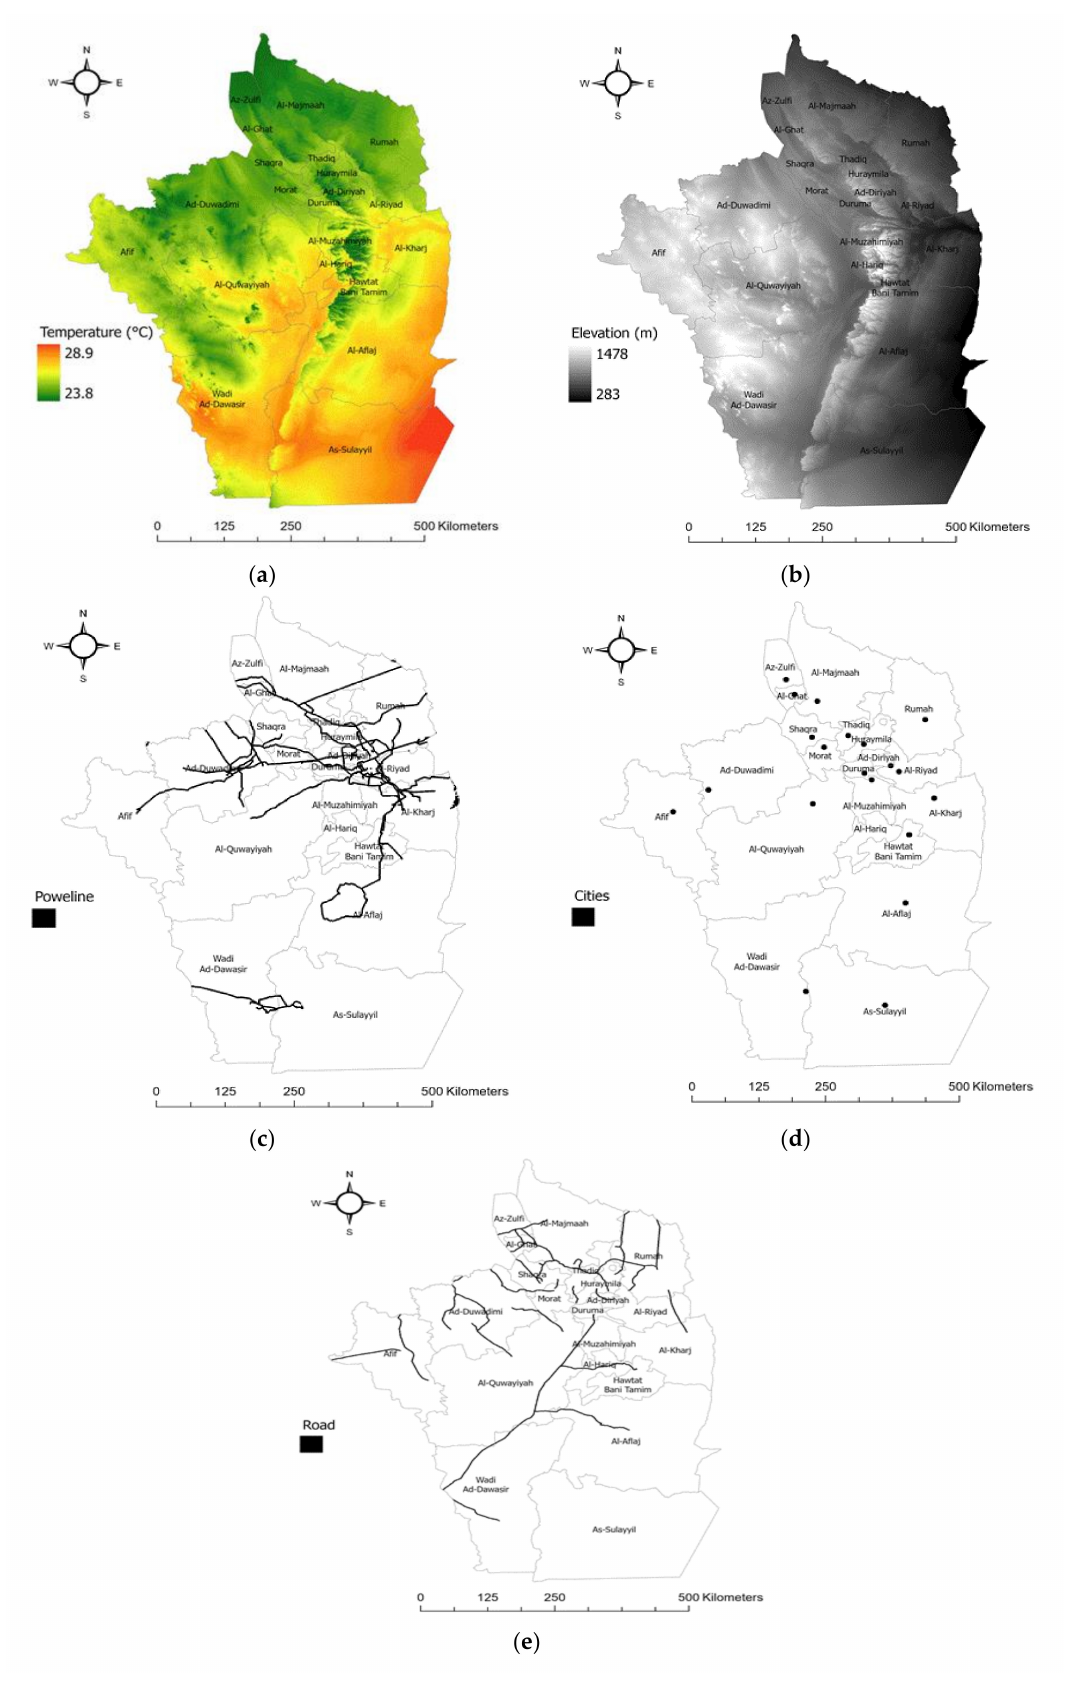
Figure 3. Criteria maps used in the proposed GIS-MCDM: ( a ) Temperature; ( b ) DEM; ( c ) power lines; ( d ) cities; ( e )